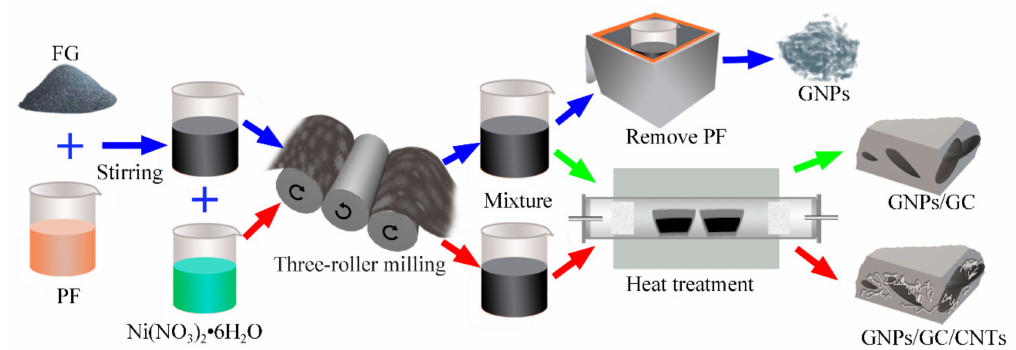
Figure 1. Preparation protocols for exfoliated Flake graphite (FG) samples (blue arrow), graphite nanoplatelets / glassy carbon (GNPs / GC) composites (green arrow), and multidimensional nanocarbon structure with GNPs / GC / carbon nanotubes (CNTs) (red